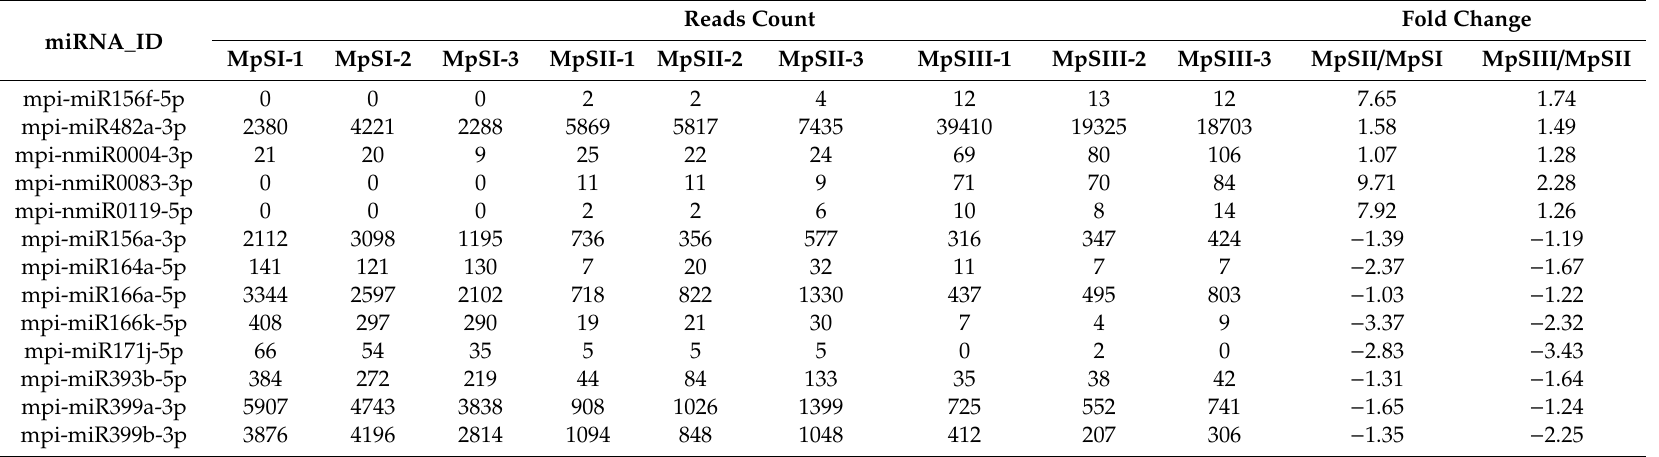
Table 2. Pongamia miRNAs with the same tendencies of expression changes in two comparisons between developmental